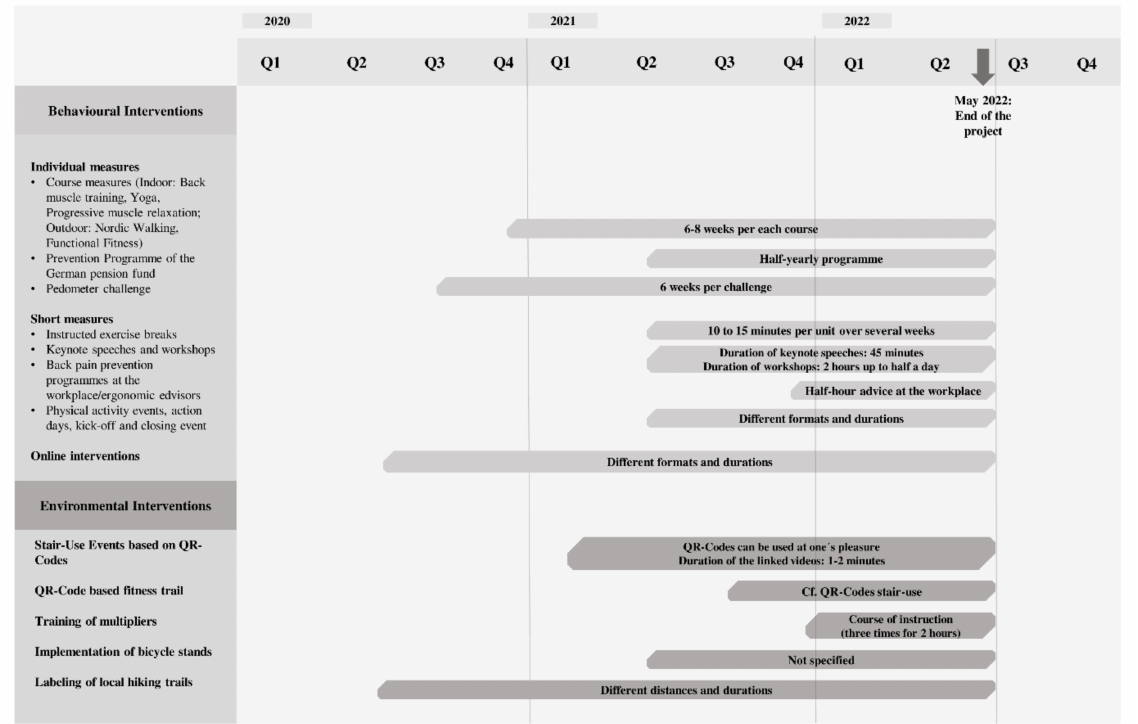
Figure 2. Measures and timetable of measures to promote physical activity in KomRueBer. Note: Q,